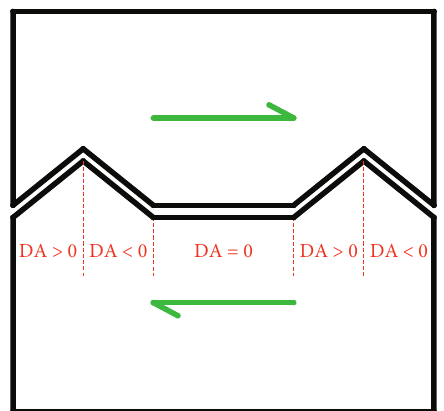
Figure 9: The diagram used to explain the positive and negative